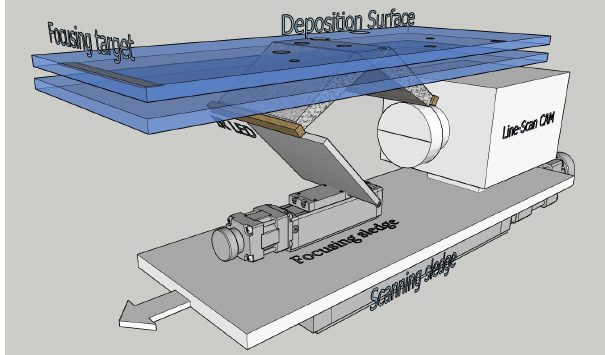
Figure 2. ICE-CAMERA basics: the scan sledge moves the image- acquisition line along the deposition surface. The focusing sledge adjusts the focus.